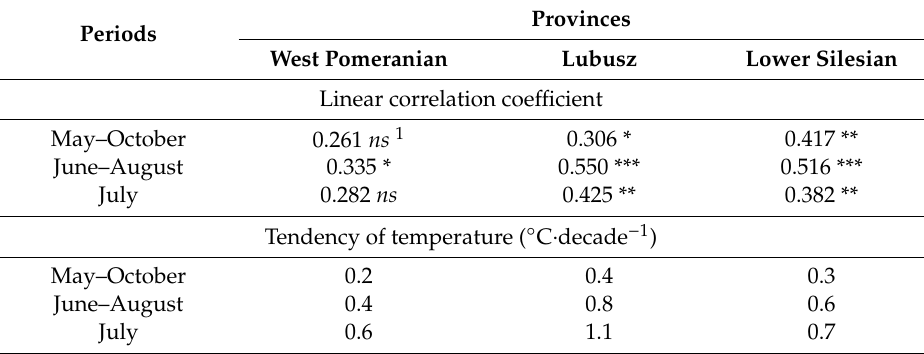
Table 7. Trend equations of air temperature in the growing season of the years 1981–2010 in the provinces of western